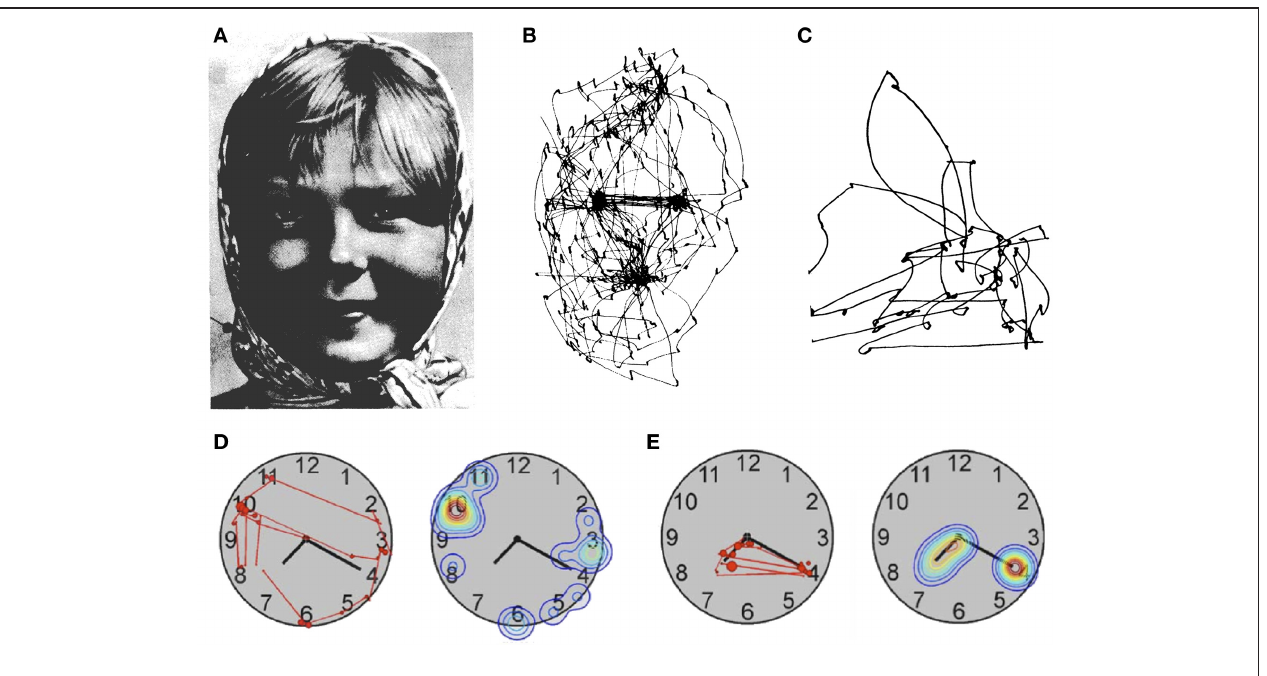
FIGURE 4 | Patterns of visual exploration in simultanagnosia. (A) Portrait used by Yarbus (1967) when studying face exploration. (B) Scan-path of a healthy subject and (C) of a patient with simultanagnosia when exploring the picture shown in (A) . (D) Scan-path